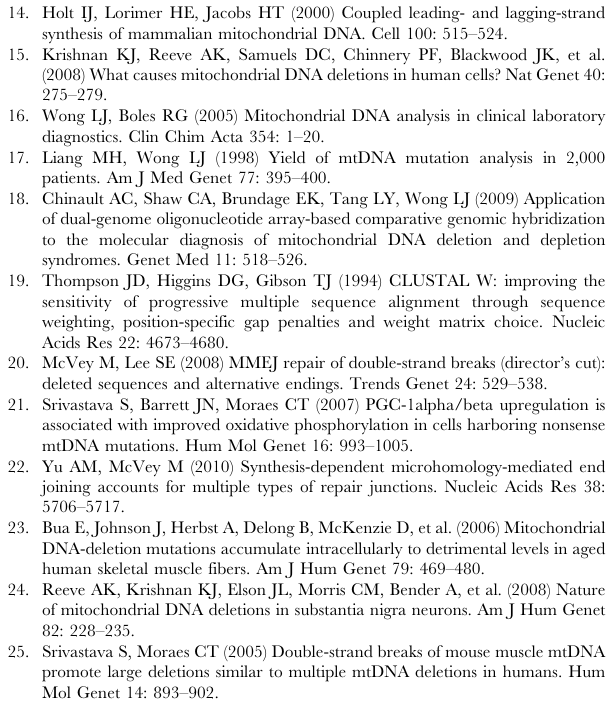
Figure S2 Analysis of sequence homology at mtDNA deletion breakpoints. The two breakpoints in each mtDNA deletion sample (Prox. and Dist. Ref.) were aligned using ClustalW alignment tool. Alignments were grouped based on the location of the breakpoint as either within a direct repeat sequence (type I), or not within a direct repeat sequence (type II). Direct repeats of 5 + nucleotides are highlighted (dark grey), and repeats of smaller size are highlighted (light gray). Mapped breakpoint nucleotides are in red. ClustalW alignments where the breakpoints do not align (in Type II breakpoints) are because, ClustalW alignment shifts the alignment to achieve maximum homology in that region. Top strand in each alignment is the proximal breakpoint sequence and bottom is the distal breakpoint sequence from Table S1. Alignments corresponding to the individual patient case from Table S1 are indicated to the left of the alignment. (TIFF) Table S1 The ‘‘breakpoint nucleotide’’ refers to the nucleotide position at which the breakpoint has occurred, either in the 5 9 or the 3 9 position. A majority of the subjects analyzed have either a single nucleotide, or a stretch of identical nucleotides (direct repeats), present at the two breakpoints flanking the deletion.